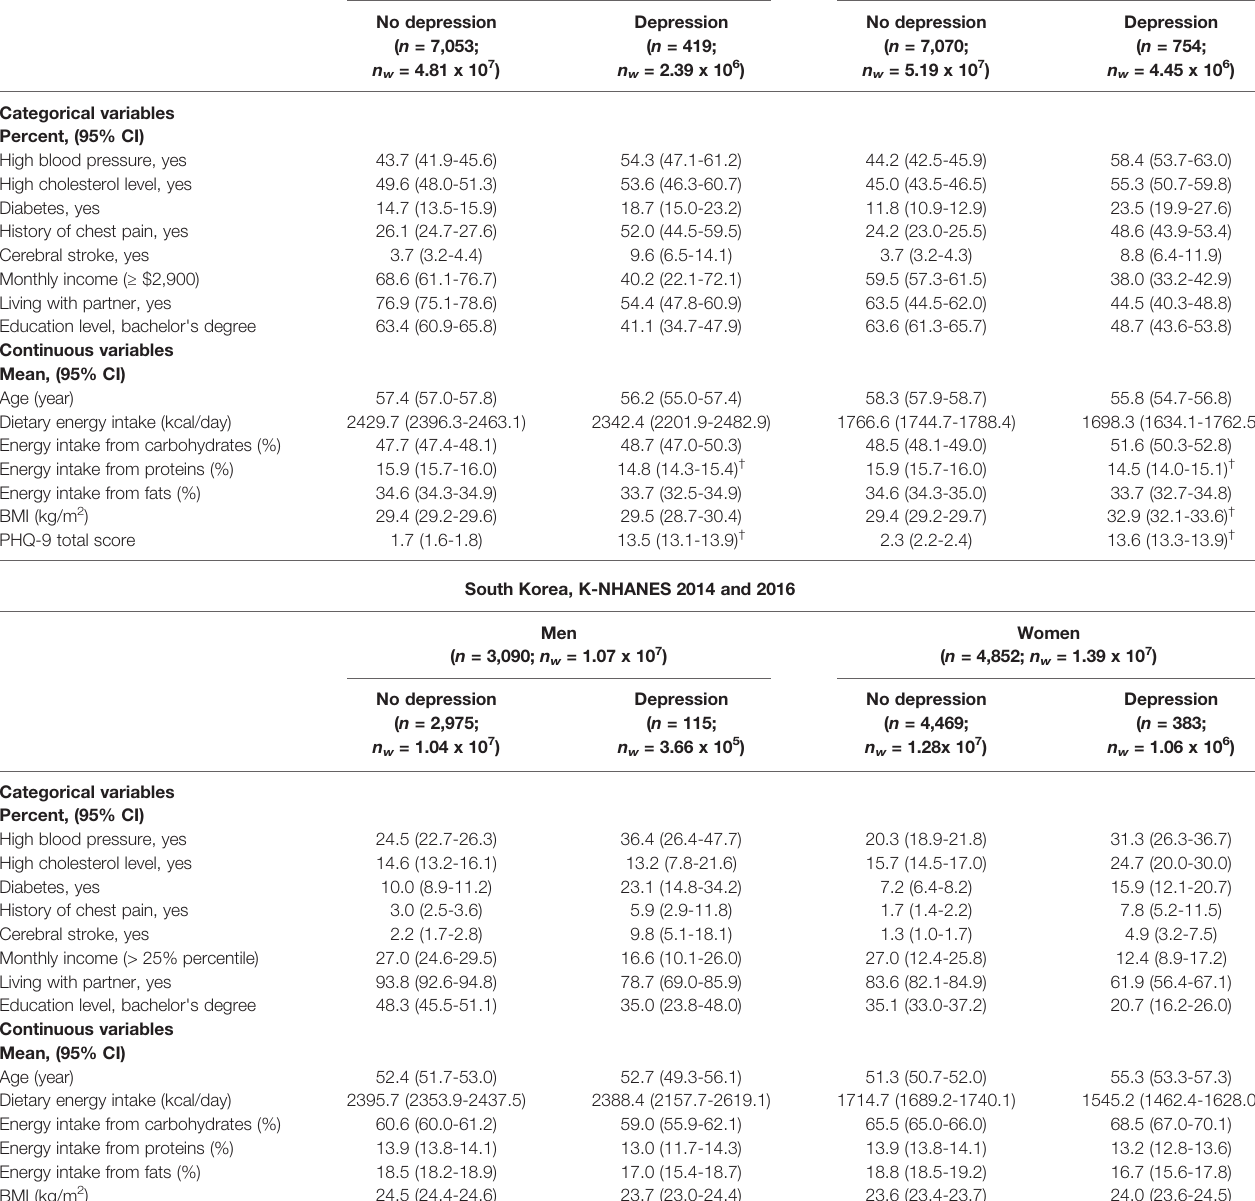
United States, NHANES